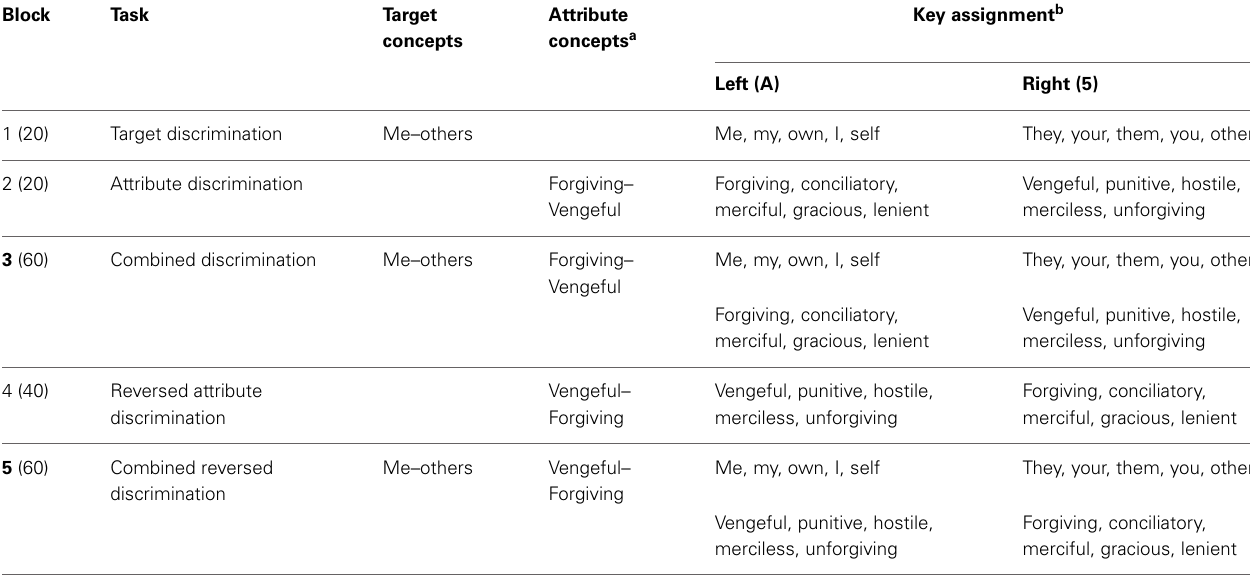
Table 1 | Forgiveness IAT: Task Sequence and